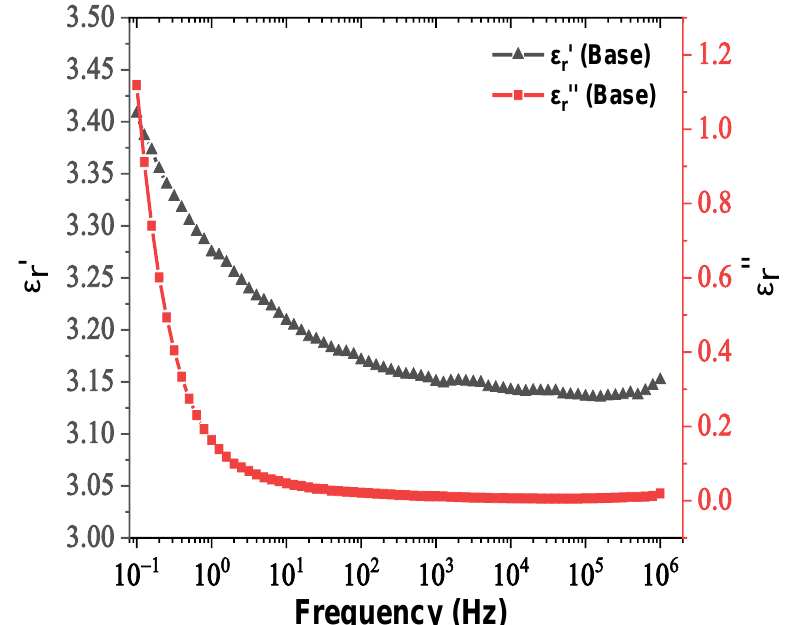
Figure 2. Change in the real and imaginary parts of relative permittivity versus frequency for natural ester oil.